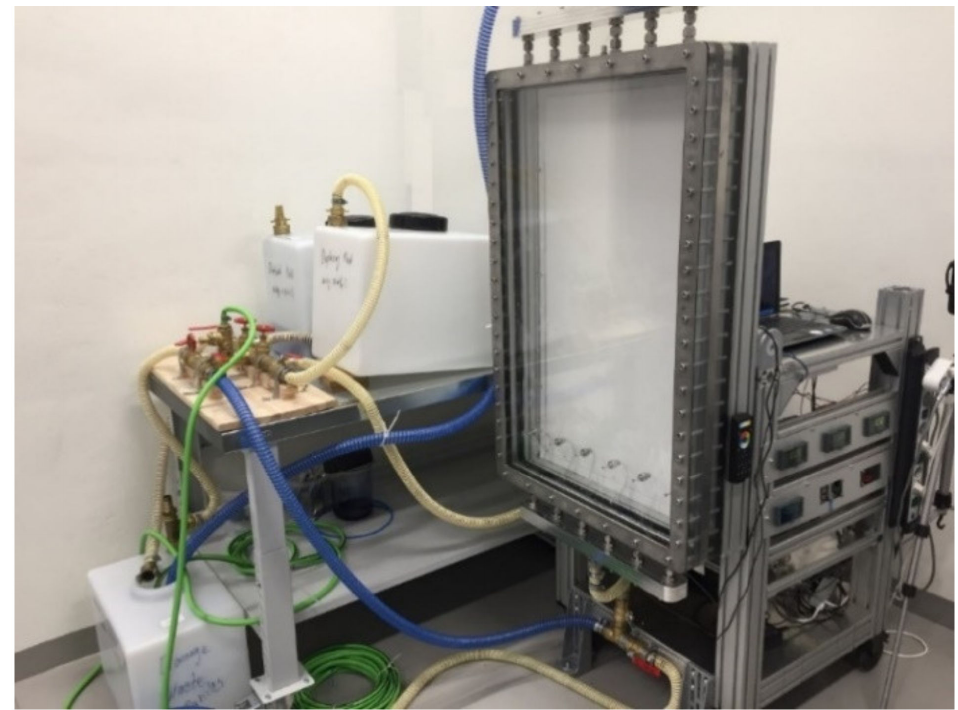
Figure 3. Experimental setup for performing the tests in the eccentric Hele–Shaw cell. Several pairs of Newtonian and non-Newtonian fluids are prepared and used in this series of experiments. Water and aqueous sucrose solution as Newtonian fluids and neutralized Carbopol-980 solutions at an intermediate pH value (using NaOH) as non- Newtonian fluids with shear-thinning and yield-stress behavior are used in this study. Brilliant Cresyl Blue was added to the displaced fluids for visualization purposes [36], sucrose was used as a weighting agent to increase the Carbopol solution density, and NaCl was added to increase electrical conductivity. Fluid densities and pHs were measured in the lab, and the rheological properties of the fluids were measured before each test using an Anton Paar MCR 102 rheometer at a fixed temperature of 21 ◦ C. The rheology data were . n γ fitted to a Herschel–Bulkley model, τ = τ y + κ , where n is the power-law index, κ is the consistency index, and τ y is the yield-stress. Table 2 presents an overview of compositions, pH, and density of the displaced and displacing fluids in the